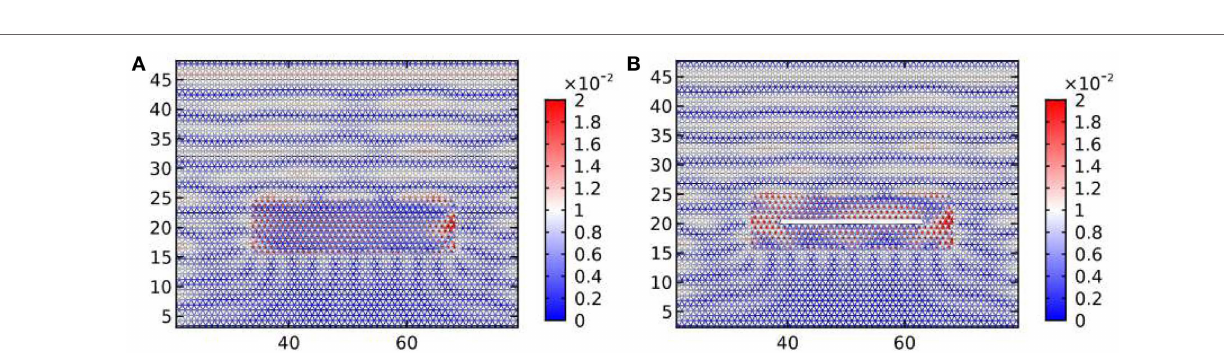
FIGURE 7 | Panel (A) shows a shear plane wave of angular frequency ω = π rad/s traveling through a homogeneous triangular lattice. In panel (B) , the same shear wave is scattered by a one-dimensional uncoated crack.